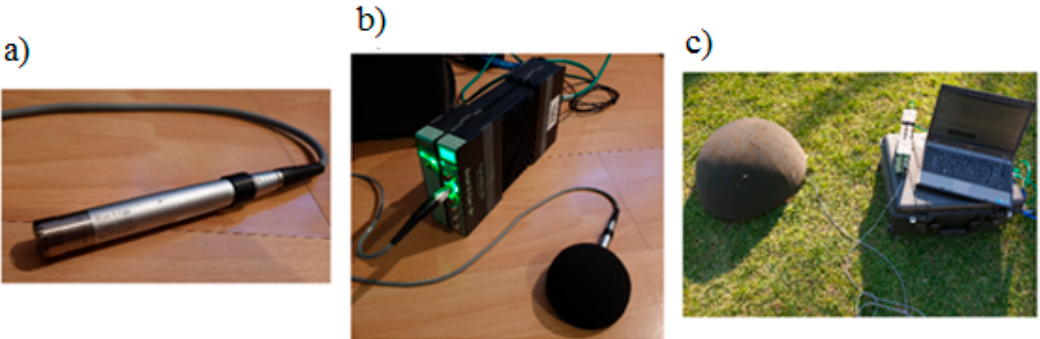
Figure 7. Used measurement system from Brüel & Kjær: ( a ) microphone, ( b ) digital meter, and ( c ) complete system.